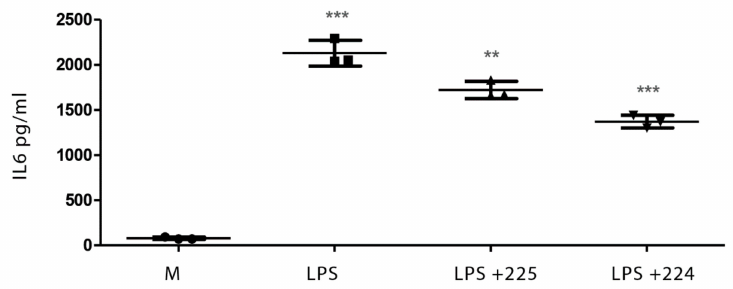
Figure 3. The e ff ect of UK propolis on IL-6 production in LPS-stimulated macrophages; n = 3 ** p value < 0.01, *** p value < 0.001. Comparisons of LPS against medium and LPS + propolis samples 224 and 225 against LPS. Medium alone =